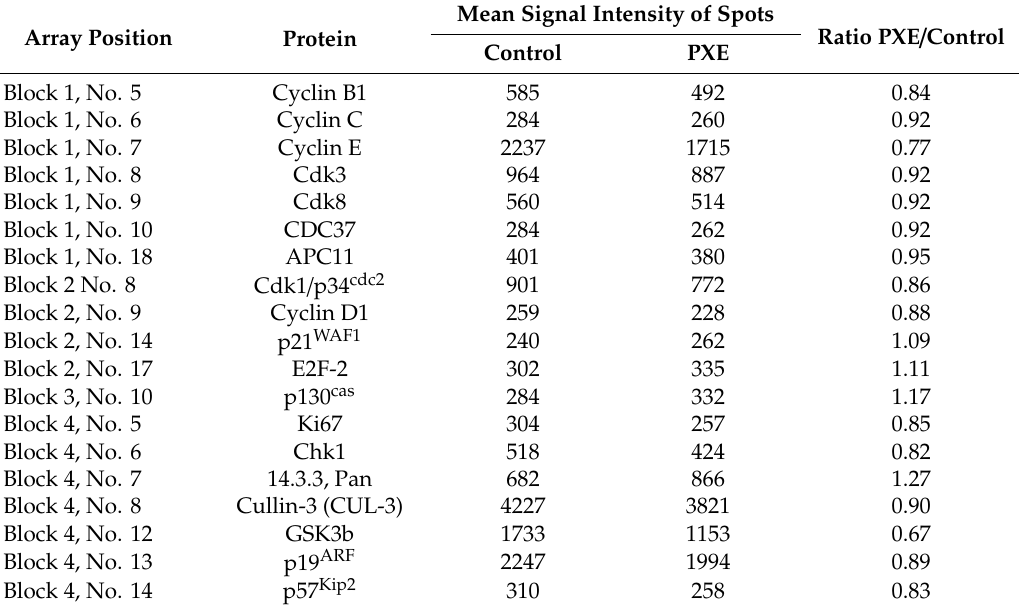
Table 1. Cell cycle antibody array data. Shown are the mean signal intensities of spots and the ratio of PXE and control. PXE / control ratios of 2 or 0.5 are considered statistically